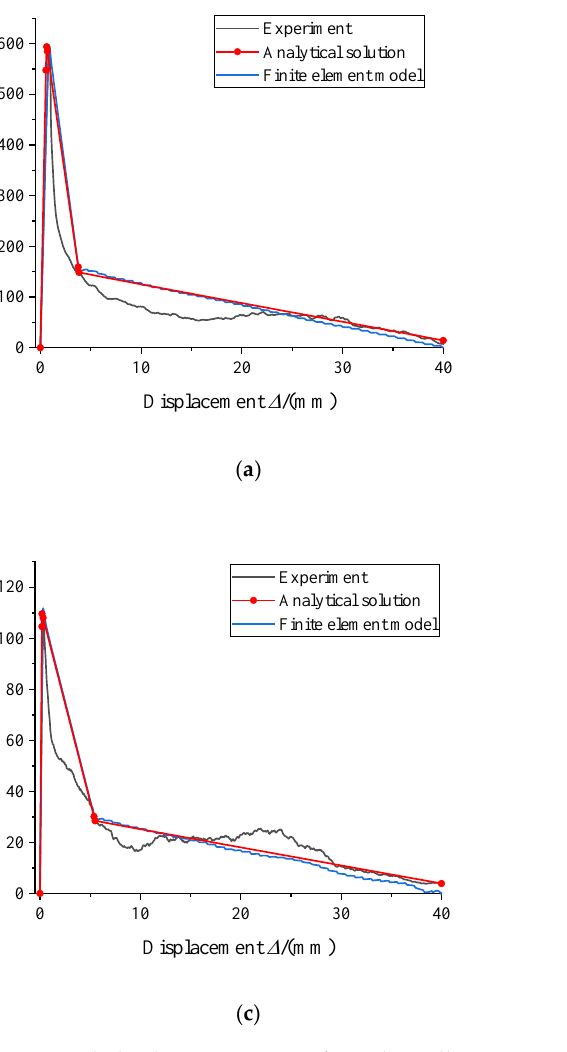
Figure 22. Load–displacement curves from the pullout tests, analytical solutions and FE simulations (group ZZ): ( a ) ZZ1: Z6011 + Zr(NO 3 ) 4 ; ( b ) ZZ2: Z6020 + Zr(NO 3 ) 4 ; ( c ) ZZ3: Z6030 + Zr(NO 3 ) 4 ; ( d ) ZZ4: Z6040 + Zr(NO 3 ) 4